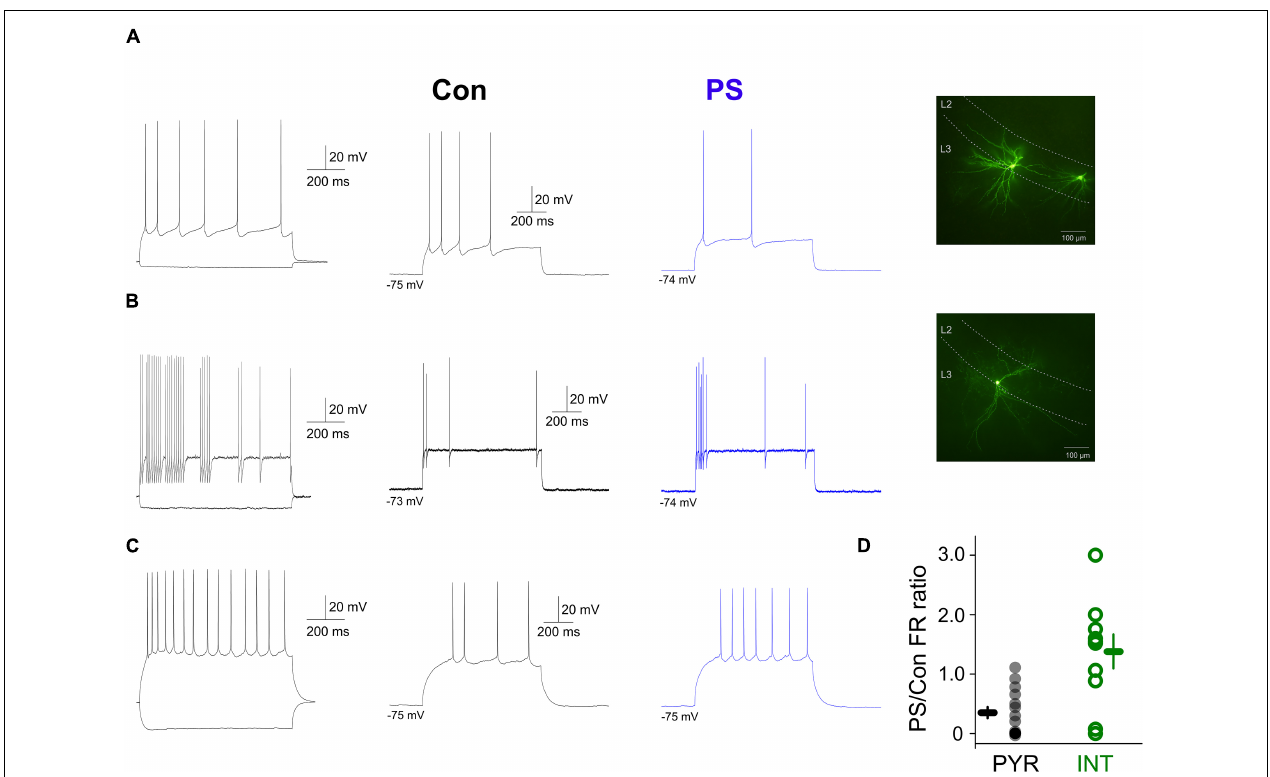
FIGURE 3 | Effects of endogenously released 5-HT on the evoked firing of aPC principal neurons and interneurons. (A) Membrane potential responses and morphology of an aPC pyramidal neuron to hyperpolarizing and depolarizing current steps in the absence (Con, black trace) and presence (PS, blue trace) of 5-HT photostimulation, respectively. (B) Membrane potential responses and morphology of an aPC interneuron to hyperpolarizing and depolarizing current steps in the absence (Con, black trace) and presence (PS, blue trace) of 5-HT photostimulation, respectively. (C) Same as panel (D) for a regular firing aPC interneuron. (D) Firing (normalized to control) of all photostimulated pyramidal neurons (PYR, gray circles, n = 16) and interneurons (INT, green circles, n =